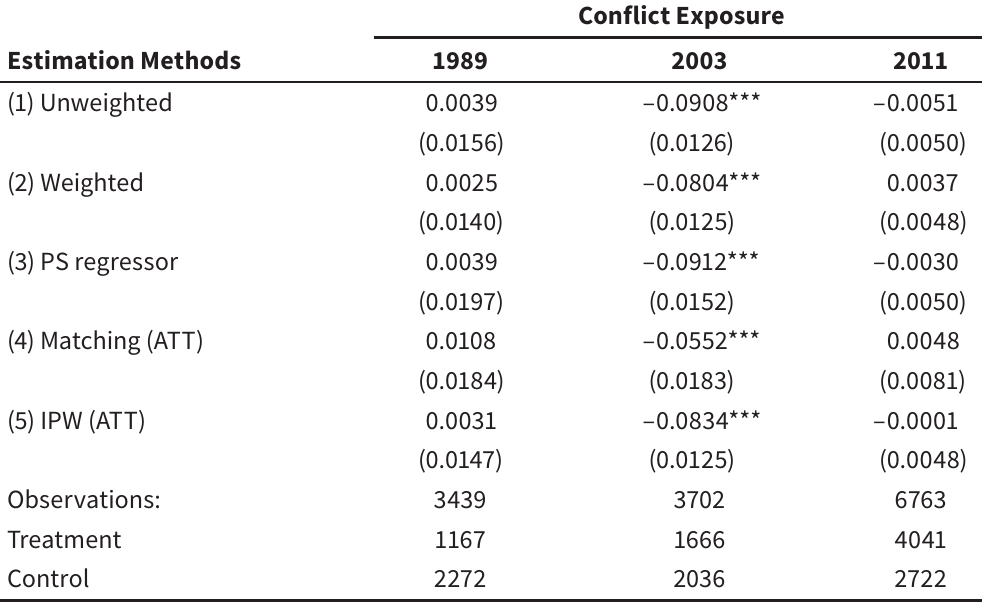
Conflict Exposure